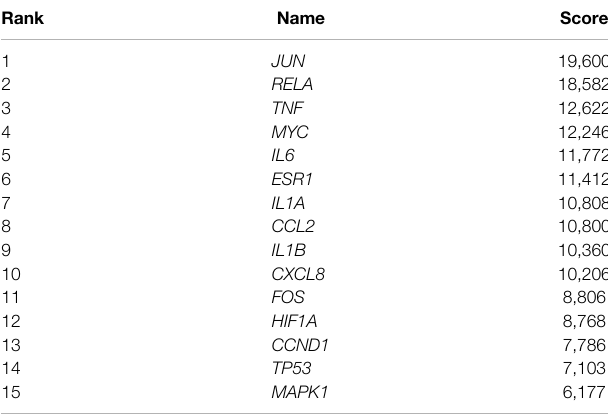
The meaning of the italic values represents the scores that were calculated using the MCC algorithm to evaluate the relationship between nodes and edges. The higher the score, the more important the gene